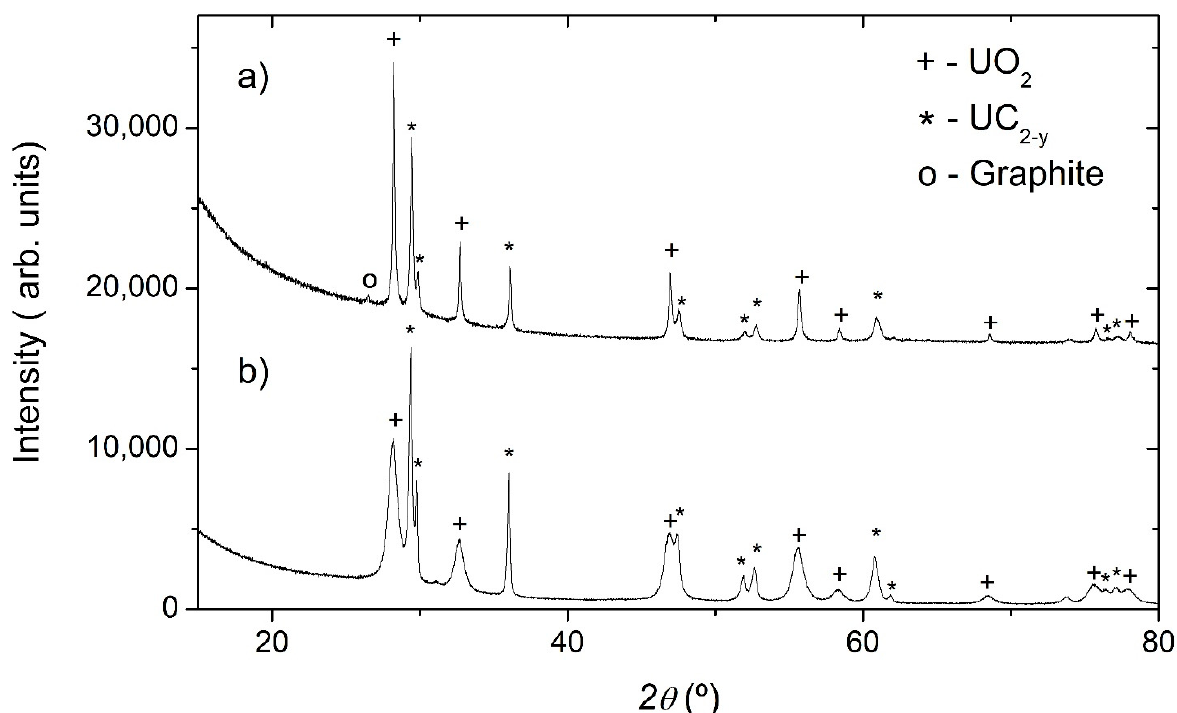
Figure 4. X-ray diffractograms of UC 2 − y material ( a ) before and ( b ) after laser heating.